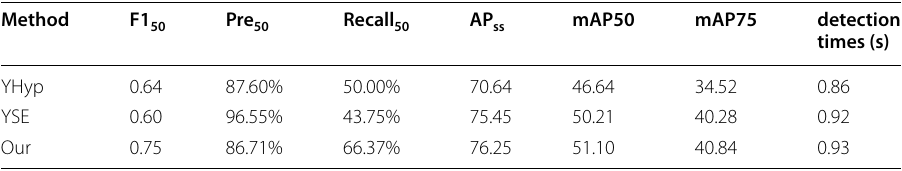
Table 1 Model test